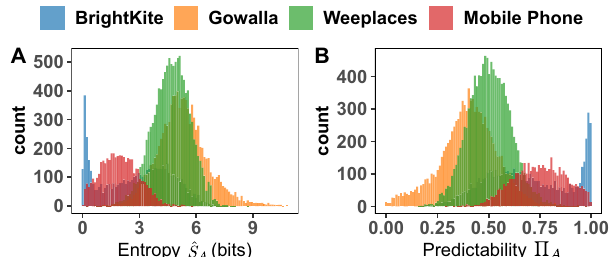
Fig. 1 Entropy and Predictability in the four mobility datasets. A The distribution of the entropy ^ S A (Eq. 1) for each of the four datasets. B The corresponding distribution of predictability Π A , calculated by inverting Eq. 2, tells us how well an ideal algorithm can predict an individual ’ s future location given their Shannon entropy 21 . In Fig. 1A, we plot